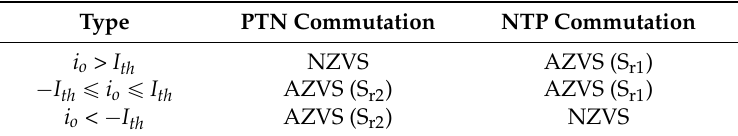
Table 3. The realization type of ZVS from zero load to full